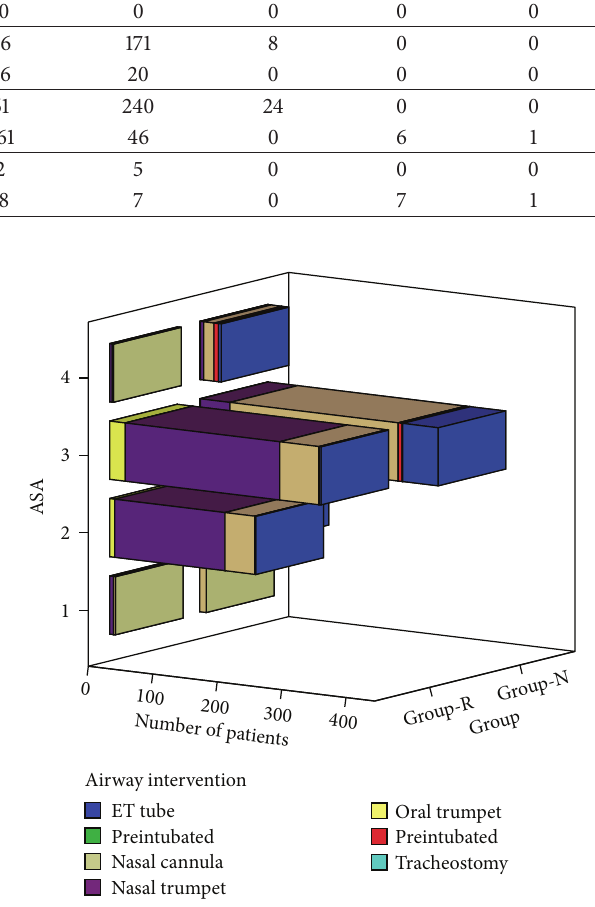
Figure2:GraphshowingnumberofpatientswithASAdistribution, airway intervention in both